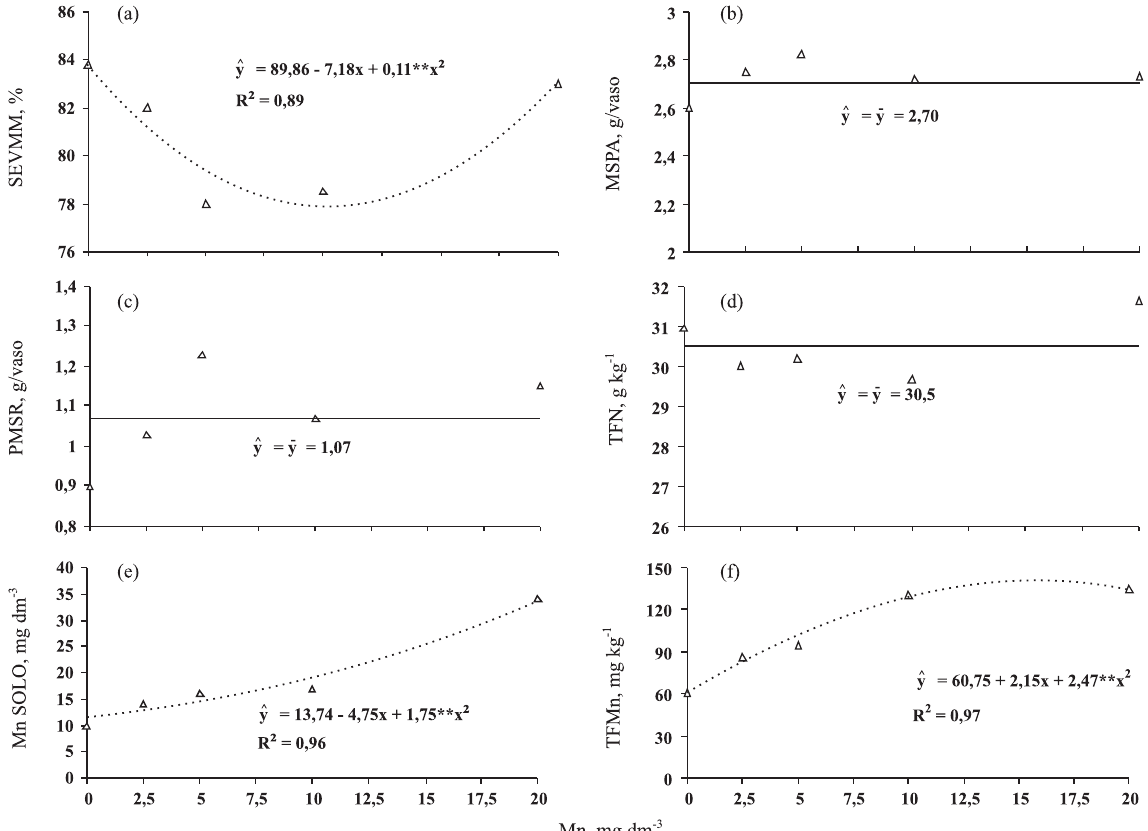
Figura 1. Severidade da mancha-marrom (a); produção de matéria seca da parte aérea (b); produção de matéria seca de raízes (c); teores de N em folhas de trigo (d); teores de Mn no solo (e); e teores de Mn em folhas de trigo (f), em plantas cultivadas em solos que receberam doses de Mn (0; 2,5; 5,0; 10,0 e 20,0 mg dm -3 ). **: significativo a 1 % pelo teste de